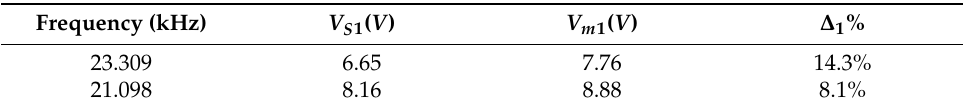
Table 6. The measured and simulated voltage values under the condition of the length for the transmission medium having 20 mm.